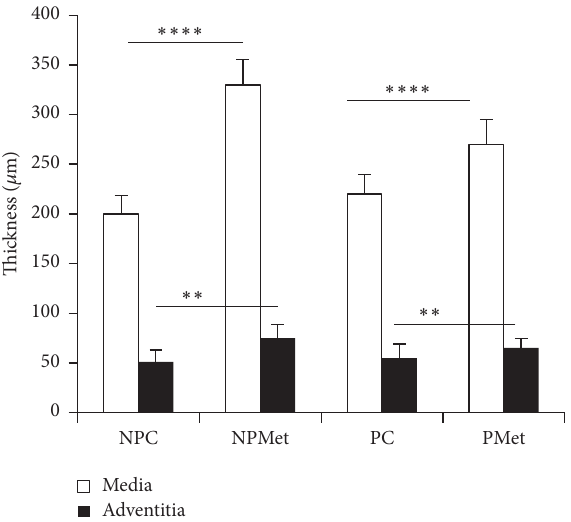
Figure 5: Aorta morphometry of the different groups of female rabbits. Comparison of NPMet versus NPC and PMet versus PC; ∗∗ 𝑝 < 0.01 . ∗∗∗∗ 𝑝 < 0.0001